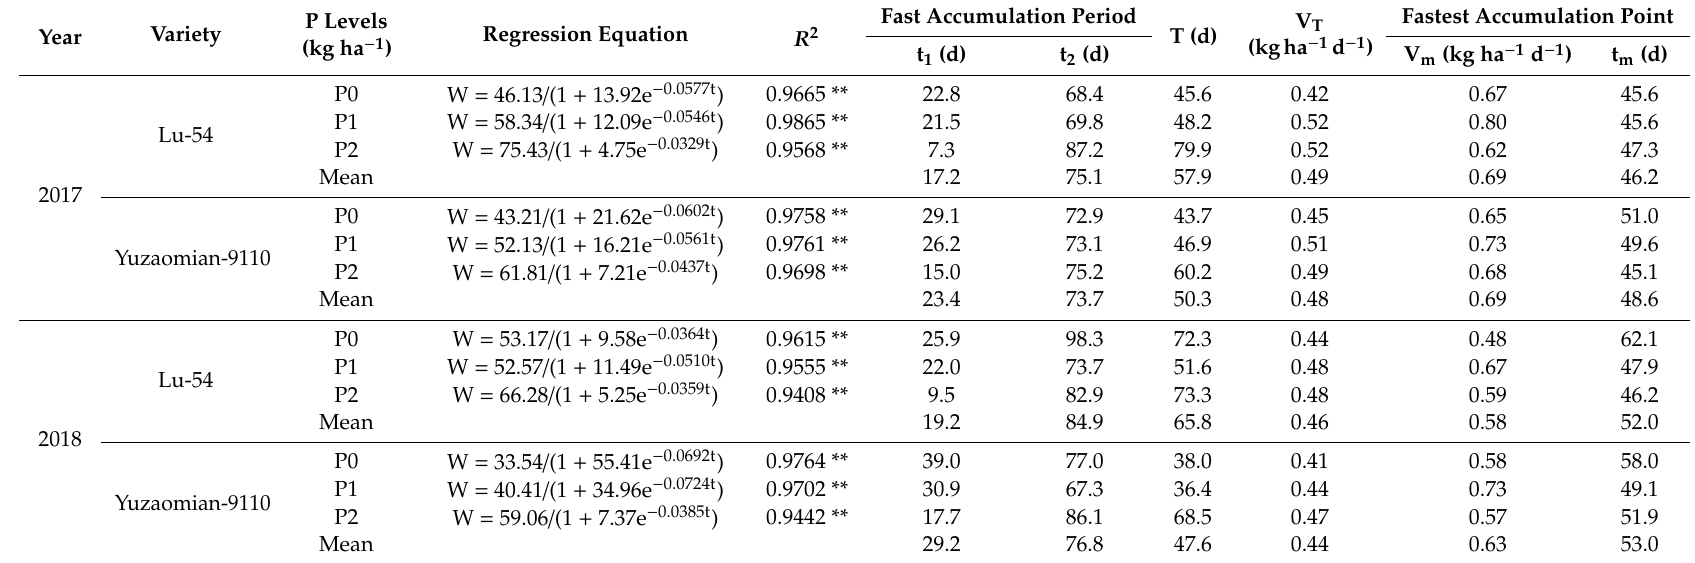
Table 4. Dynamic models and the maximum accumulation rate of K (V M ), average speed of K accumulation (V T ), start time of the K rapid-accumulation period (t 1 ), termination time of the K rapid-accumulation period (t 2 ), duration of the K rapid-accumulation period (T), and occurrence time of maximum accumulation rate of K (t m ) in reproductive organ of cotton plants for Lu-54 and Yuzaomian-9110 in 2017 and